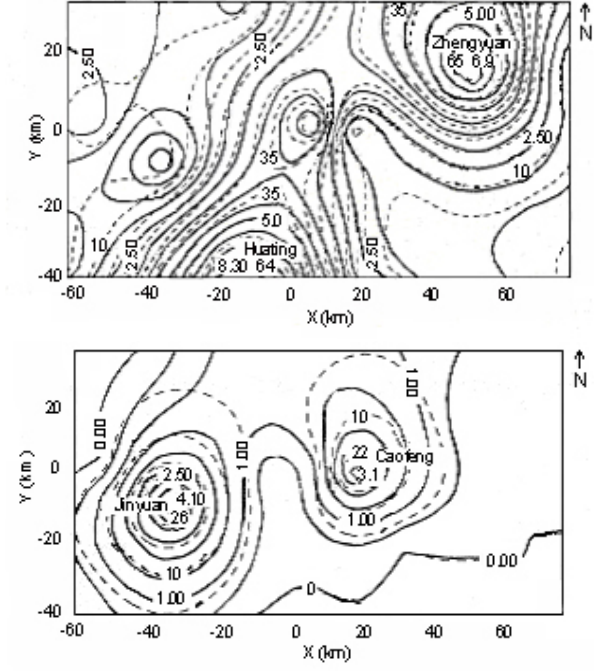
Fig. 5. The isolines of the distribution of the average precipitation intensity (solid line) in the main precipitation period (14:00–20:00) and the isolines of the distribution of the number of CG lightning flashes (dashed line) in the same period: (a) 27 July, (b) 30